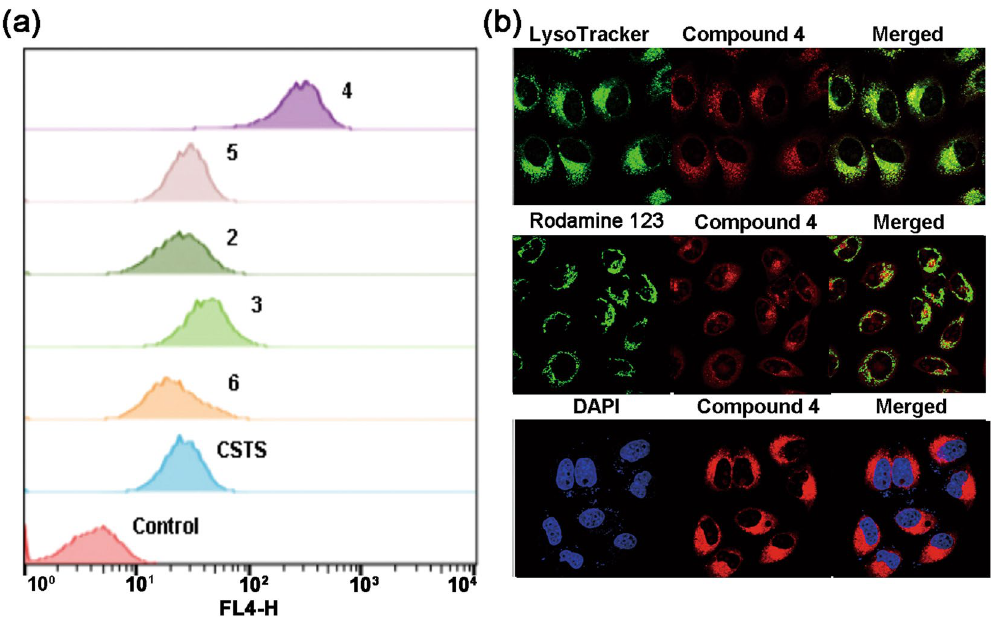
Figure 6. ( a ) Flow cytometry histogram of MCF-7 cells after incubated with compounds; ( b ) Confocal imaging of MCF-7 cells stained with compound 4 (2 μ M) ( λ ex = 635 nm) and Rodamine 123 (1 μ M) ( λ ex = 488